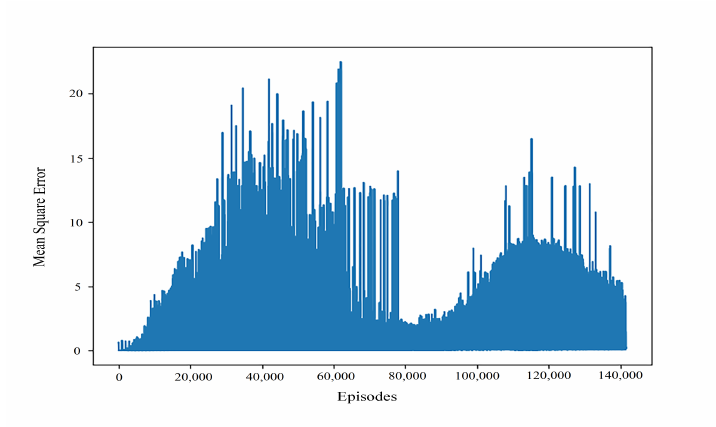
Figure 4. General performance of the mean square error convergence with a learning rate of